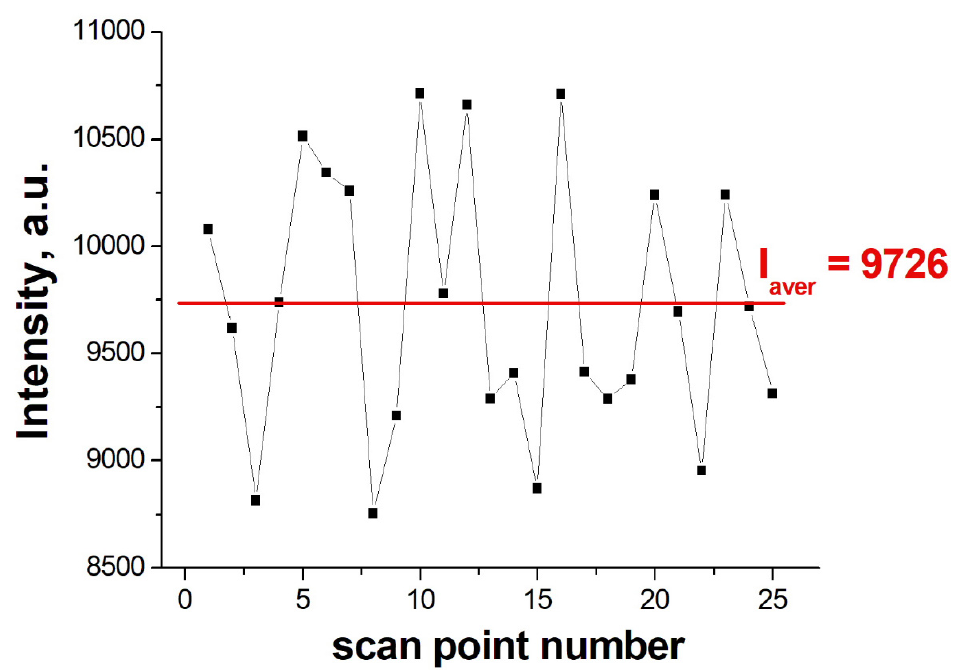
Figure 3 . Distribution of the SERS signal over the substrate surface. The relative standard deviation was was 6.2%.